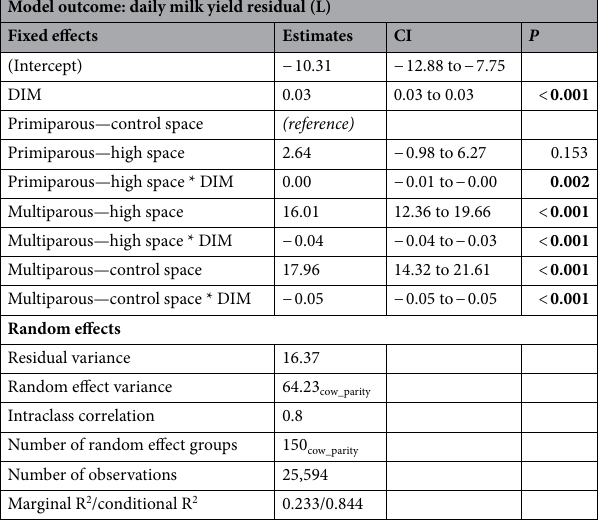
Table 1. Table of mixed effects model estimates for prediction of the daily milk volume residuals calculated from the non-linear model, using days in milk (DIM), parity and trial group (with interactions) as covariates, using data from a long-term randomised controlled trial to evaluate the impact of living space on dairy cow productivity, reproductive biology and welfare. Significant values are in